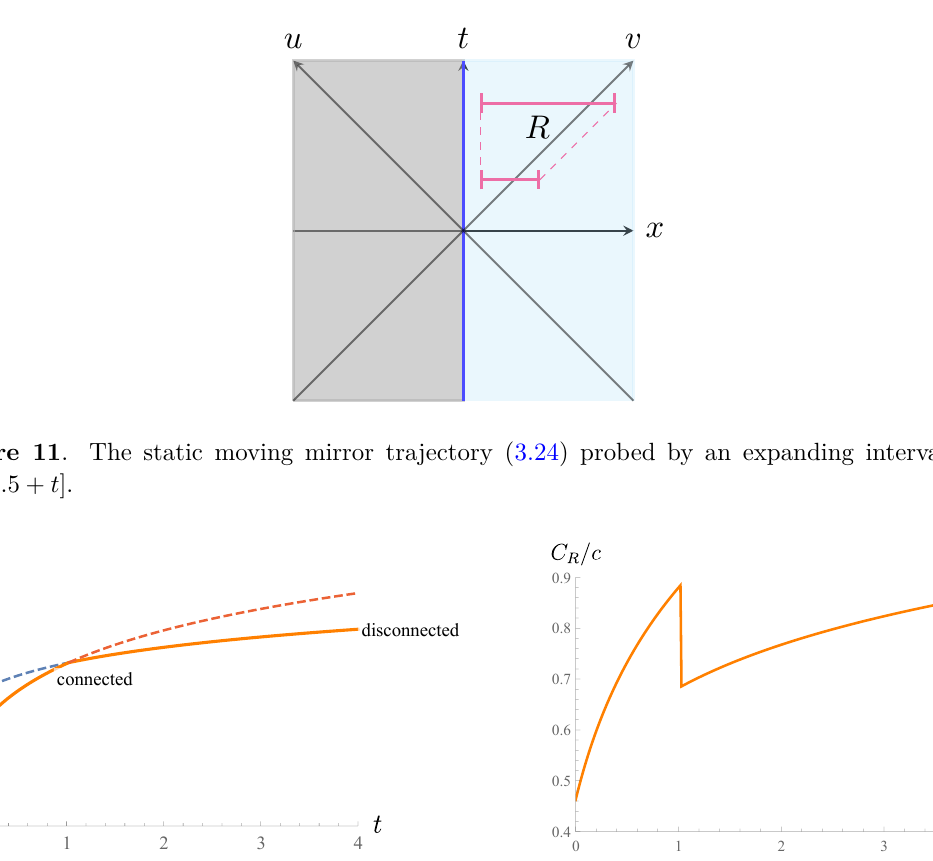
Figure 12 . The entropy [Left] and capacity [Right] in the static mirror model probed by an expanding interval. We set the subsystem to be R = [0 . 1 , 0 . 5 + t ] with (cid:15) = 0 . 1 and S bdy /c = 0 . 1 . There is a phase transition from the connected channel to disconnected one, and the capacity drops down by 2 S bdy = 0 . 2 c at the transition